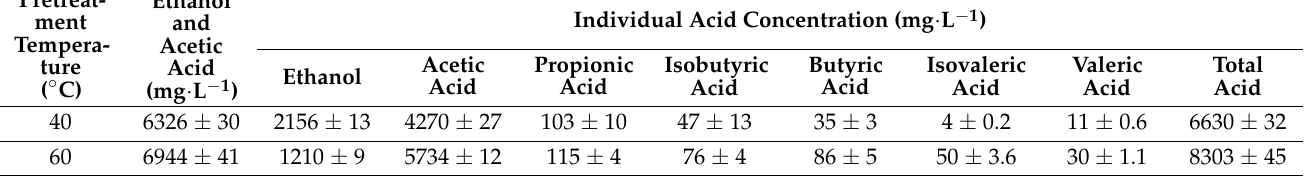
Figure 2. Individual VFAs and Ethanol concentrations of CS pretreated by 40 ◦ C and 60 ◦ C conditions. Table 3. Comparisons of TVFAs under different pretreatment conditions *.